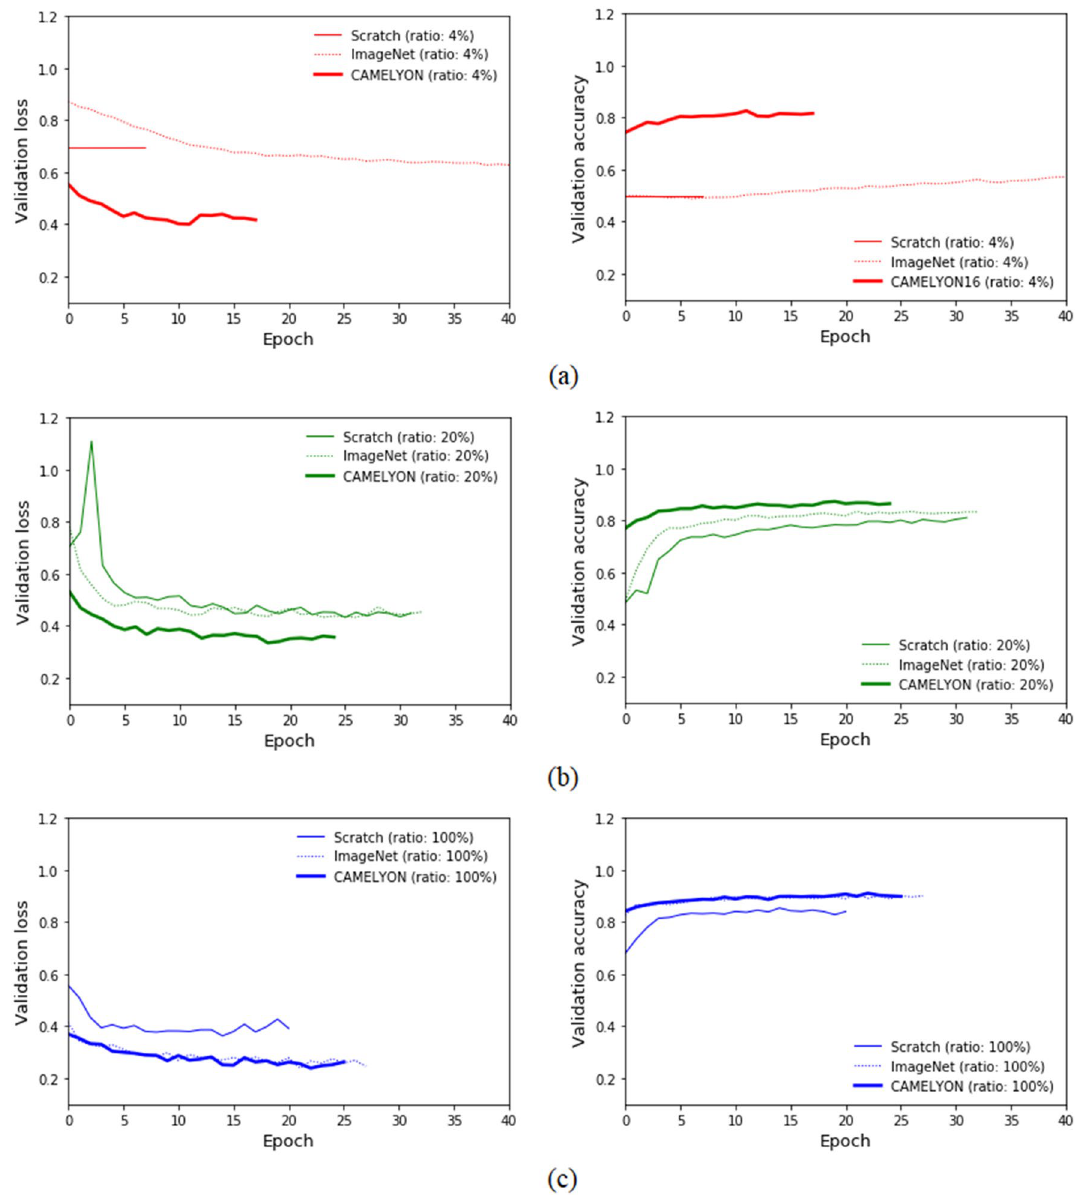
Figure 2. Validation loss and accuracy comparison of scratch-, ImageNet-, and CAMELYON16-based models for different AMC dataset ratios. ( a ) 4%, ( b ) 20%, ( c ) 100% of the total training